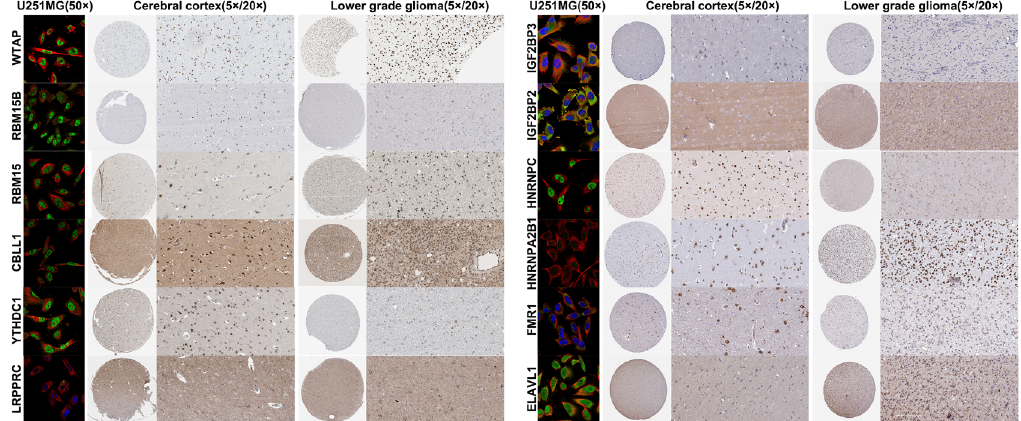
Figure 2. Immunofluorescence and immunohistochemistry of m 6 A-related regulatory proteins in cerebral cortex and low-grade gliomas